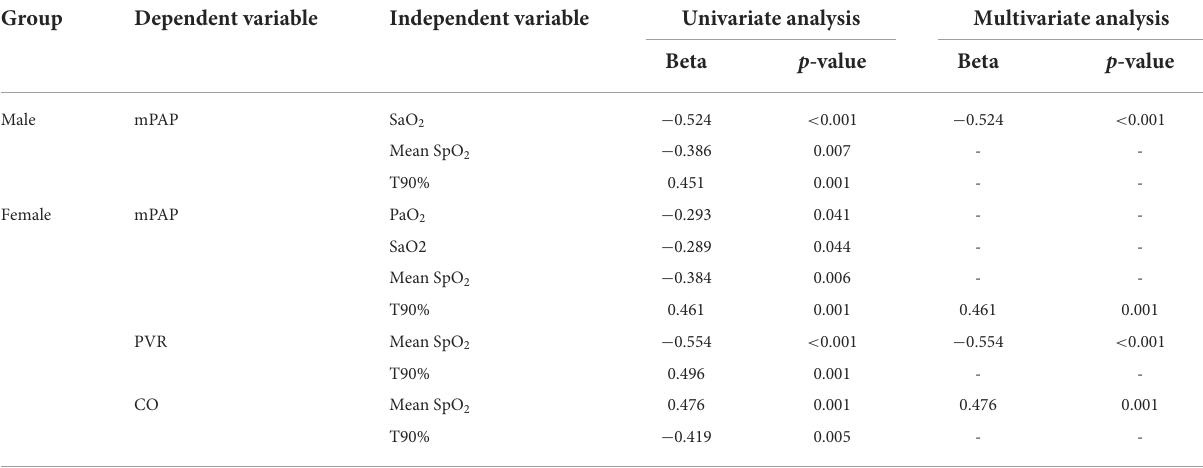
TABLE 3 Hypoxemia-related indicators associated with PVR, mPAP and CO in male and female patients with CTEPH and CTEPD.